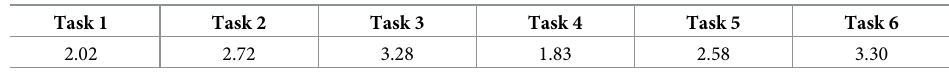
Table 5. β values of the anatomical NPS.